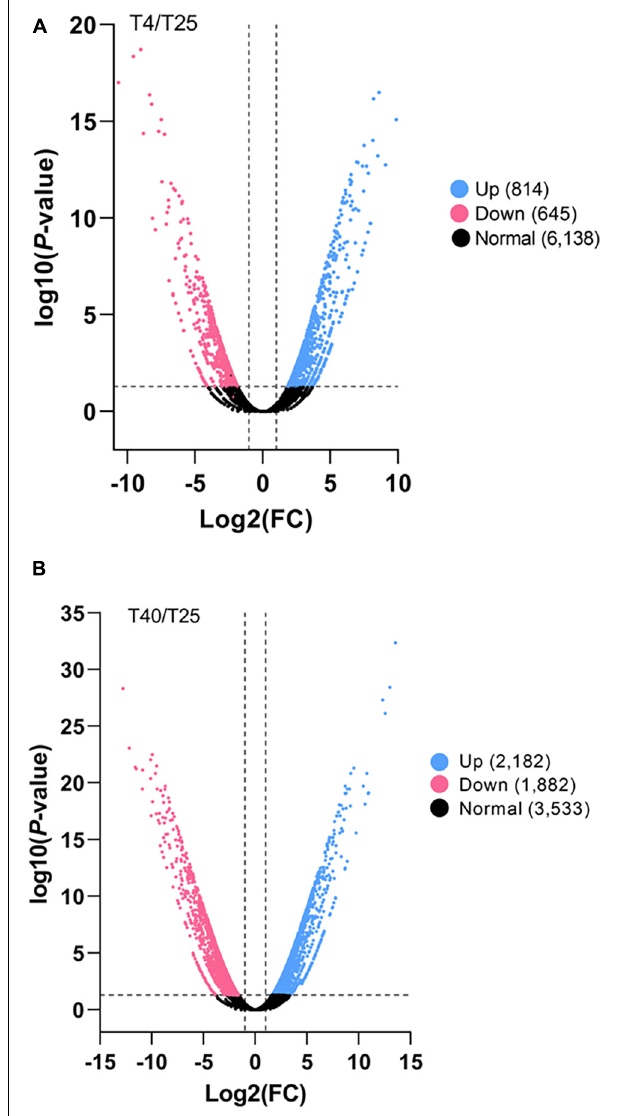
FIGURE 3 | Significant differentially expressed gene (DEG) analysis. The number of all up and down regulated contigs based on P -value < 0.05 and log 2 FC ≥ 2 or log 2 FC ≤ –2 of comparison pairs was plotted. Volcano diagram for distribution of the identified DEGs in treatment groups (A) T4 and (B) T40, in comparison with T25 as control was plotted. Red and blue points represent the significant DEGs that down-regulated or up-regulated, respectively and black ones show those without significant